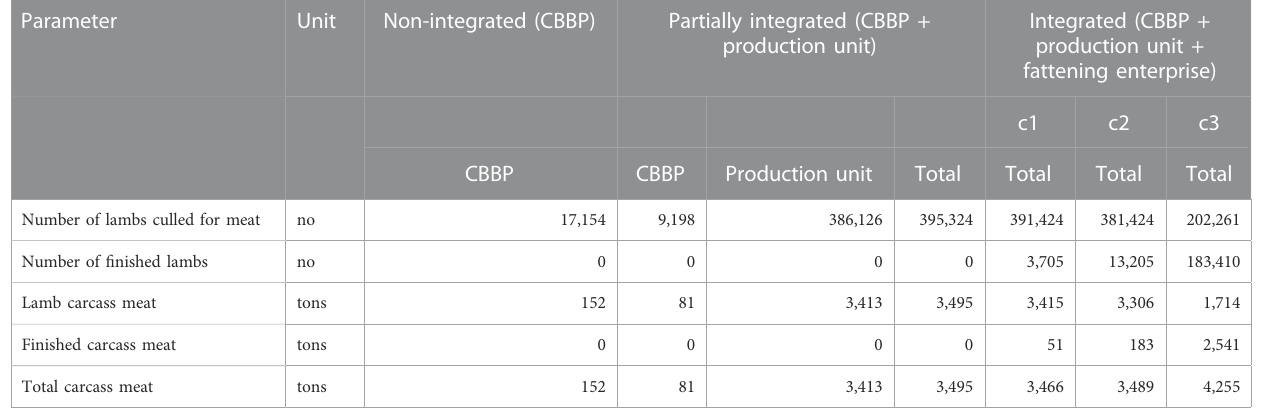
TABLE 3 Yearly lamb and carcass meat production in three integration scenarios of CBBPs, production units and fattening enterprises, excluding the effect of genetic improvement. Based on current 28 CBBPs and three levels of expected fi nal fattening capacity (c1, c2, and c3) described in section 2.5.